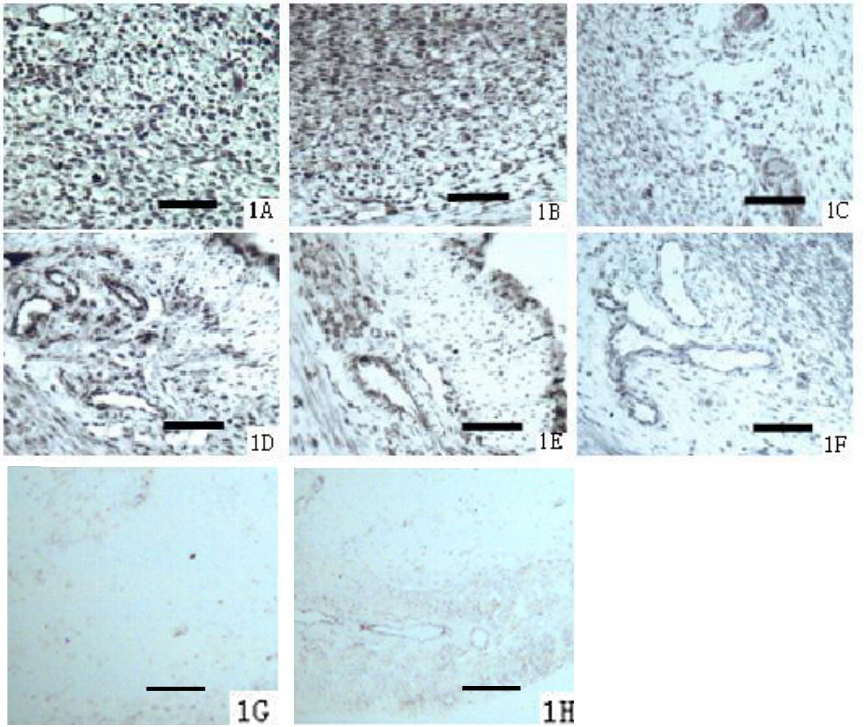
Figure 1. Effect of IFN-  on IL-18 expression in the uterus of pregnant rats (Scale bar = 50  m). 1A. IL-18 expression in uterine endometrium or deciduas of the control group (400  ). 1B. IL-18 expression in uterine endometrium or deciduas of the L-IFN-  group (400  ). 1C. IL-18 expression in uterine endometrium or deciduas of the H-IFN-  group (400  ). 1D. IL-18 expression in uterine myometrium of the control group (400  ). 1E. IL-18 expression in uterine myometrium of the L-IFN-  group (400  ). 1F. IL-18 expression in uterine myometrium of the H-IFN-  group (400  ). 1G. Isotype control staining of IL-18 Ab in uterine endometrium or deciduas (400  ). 1H. Isotype control staining of IL-18 Ab in uterine myometrium (400 